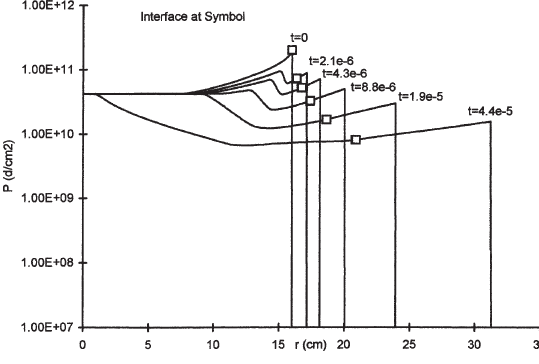
Fig. 1. Non-Uniform Euler Model initial expansion